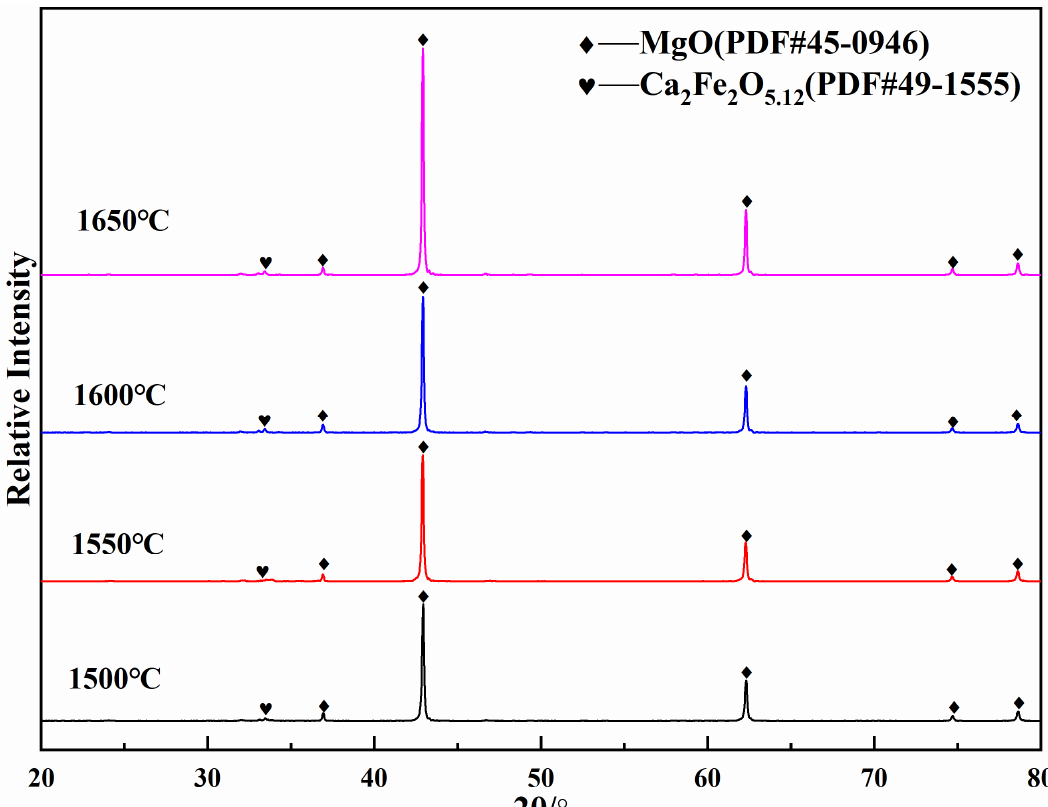
Figure 3. Diffraction results for the MgO-CaO-Fe 2 O 3 clinker fired at different